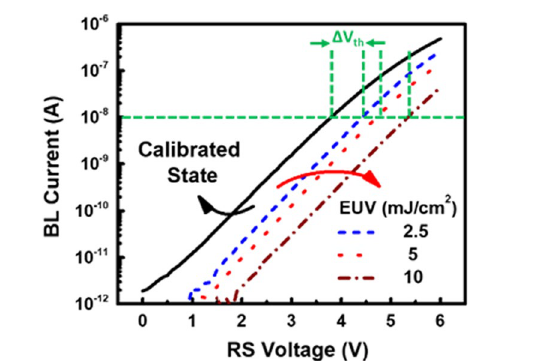
Fig. 9 The measured IV characteristics of a discrete micro‑detector with increasing amount of EUV energy applied